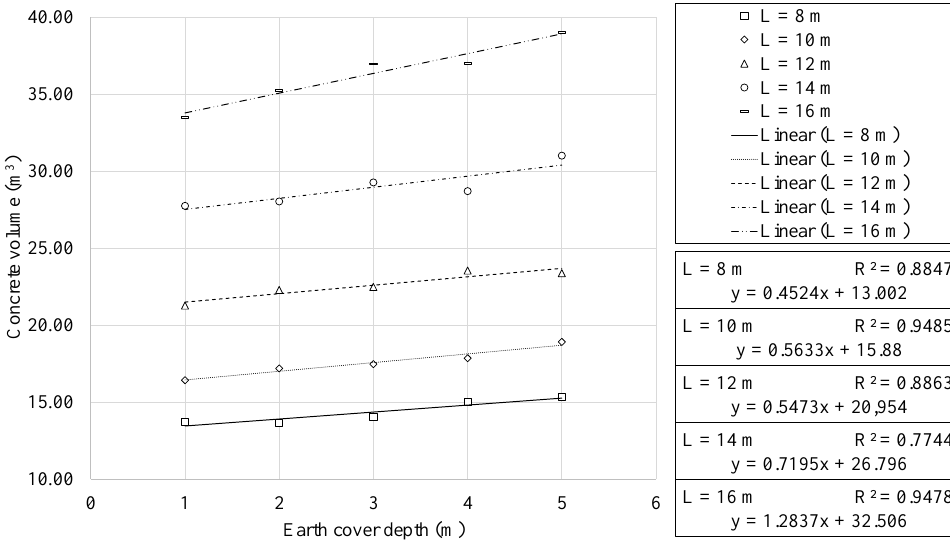
Figure 10. Concrete volume as function of earth cover depth, for each horizontal